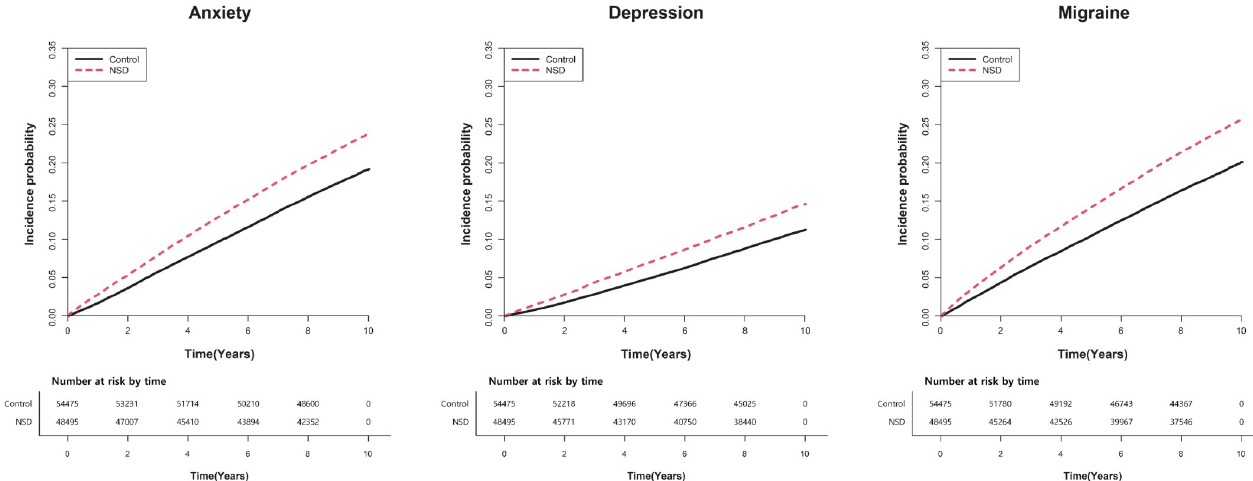
Fig 2. Kaplan–Meier curves of the incidence of anxiety, depression, and migraine in patients with NSD. Anxiety, depression, and migraine occur more frequently in the NSD group compared to the control group.